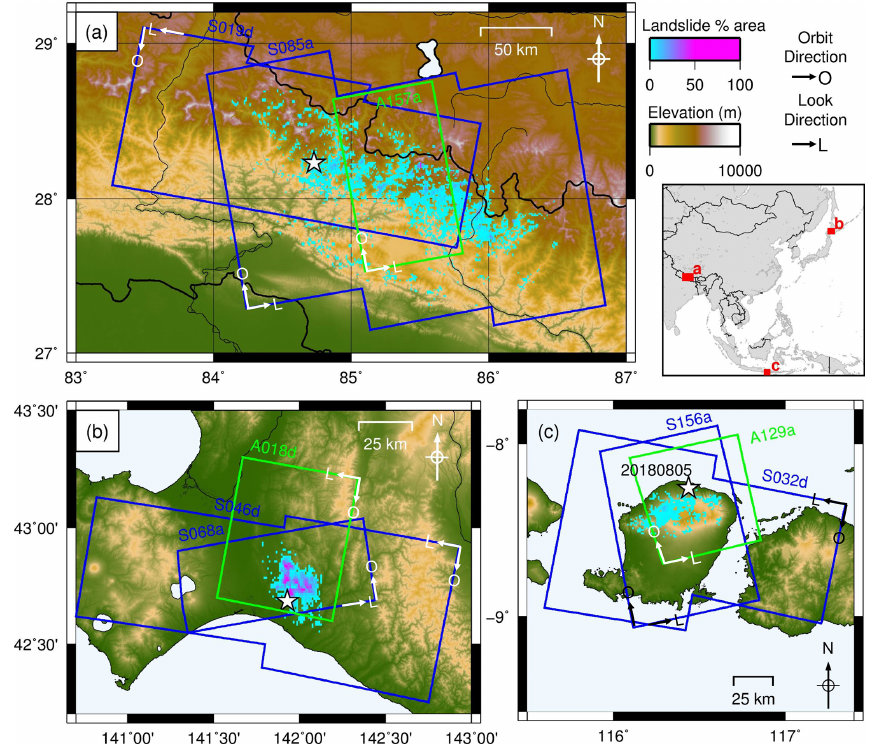
Figure 1. SAR coverage of the three case study regions: (a) the 2015 Gorkha, Nepal, earthquake; (b) the 2018 Hokkaido, Japan, earthquake; and (c) the 2018 Lombok, Indonesia, earthquake. Sentinel-1 scenes shown in blue. ALOS-2 scenes shown in green. Landslide data from Ferrario (2019), Roback et al. (2017) and Zhang et al. (2019). White stars show earthquake epicentres. White arrows show satellite orbit (O) and look direction (L). Adapted from Burrows et al.